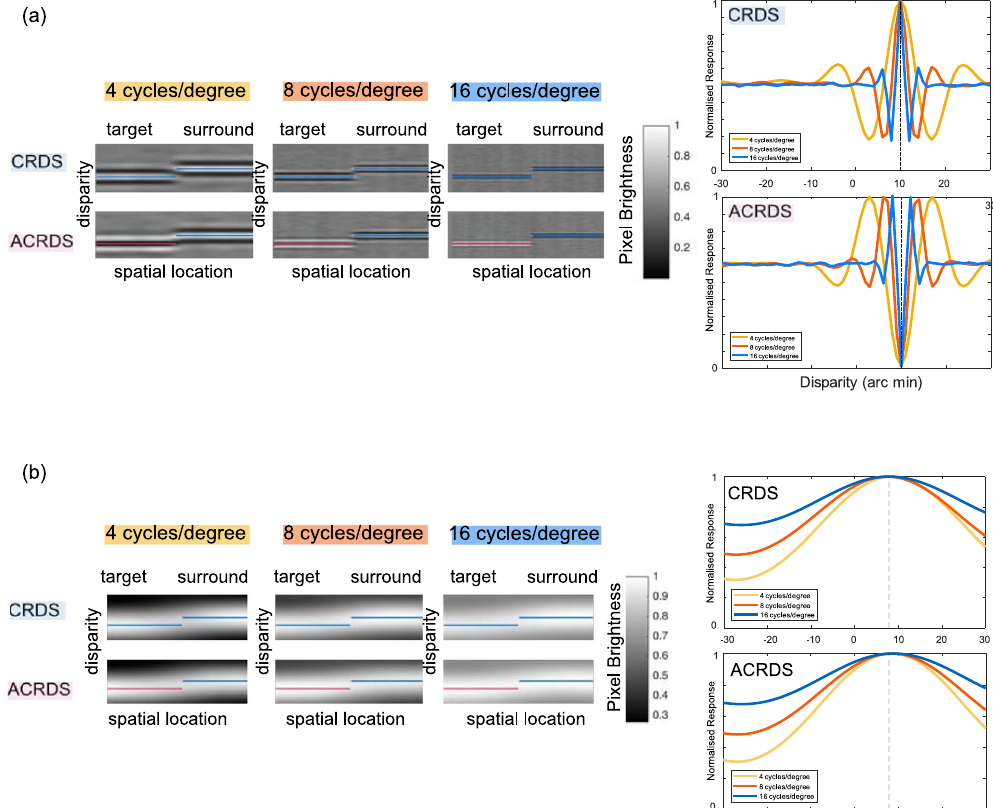
Figure 11. ( a ) The responses of first-order mechanisms, tuned to 4, 8 and 16 cycles/degree, to CRDS (top row) and ACRDS (bottom row). In each image, horizontal and vertical position represent the spatial location and preferred disparity of the filters, respectively, and pixel brightness the strength of response. The target (correlated or anticorrelated) is on the left of each image and the zero-disparity surround is on the right. The disparities of these are indicated by the horizontal lines (blue for correlated regions, pink for anti-correlated regions). The two graphs on the right show the disparity tuning, averaged over the target regions, for all three frequencies, for CRDS (top) and ACRDS (bottom). ( b ) The responses of second-order mechanisms, with first- stage filters tuned to 4, 8 and 16 cycles/degree, to CRDS (top row) and ACRDS (bottom row). The second stage filters are in all cases tuned to 0.8